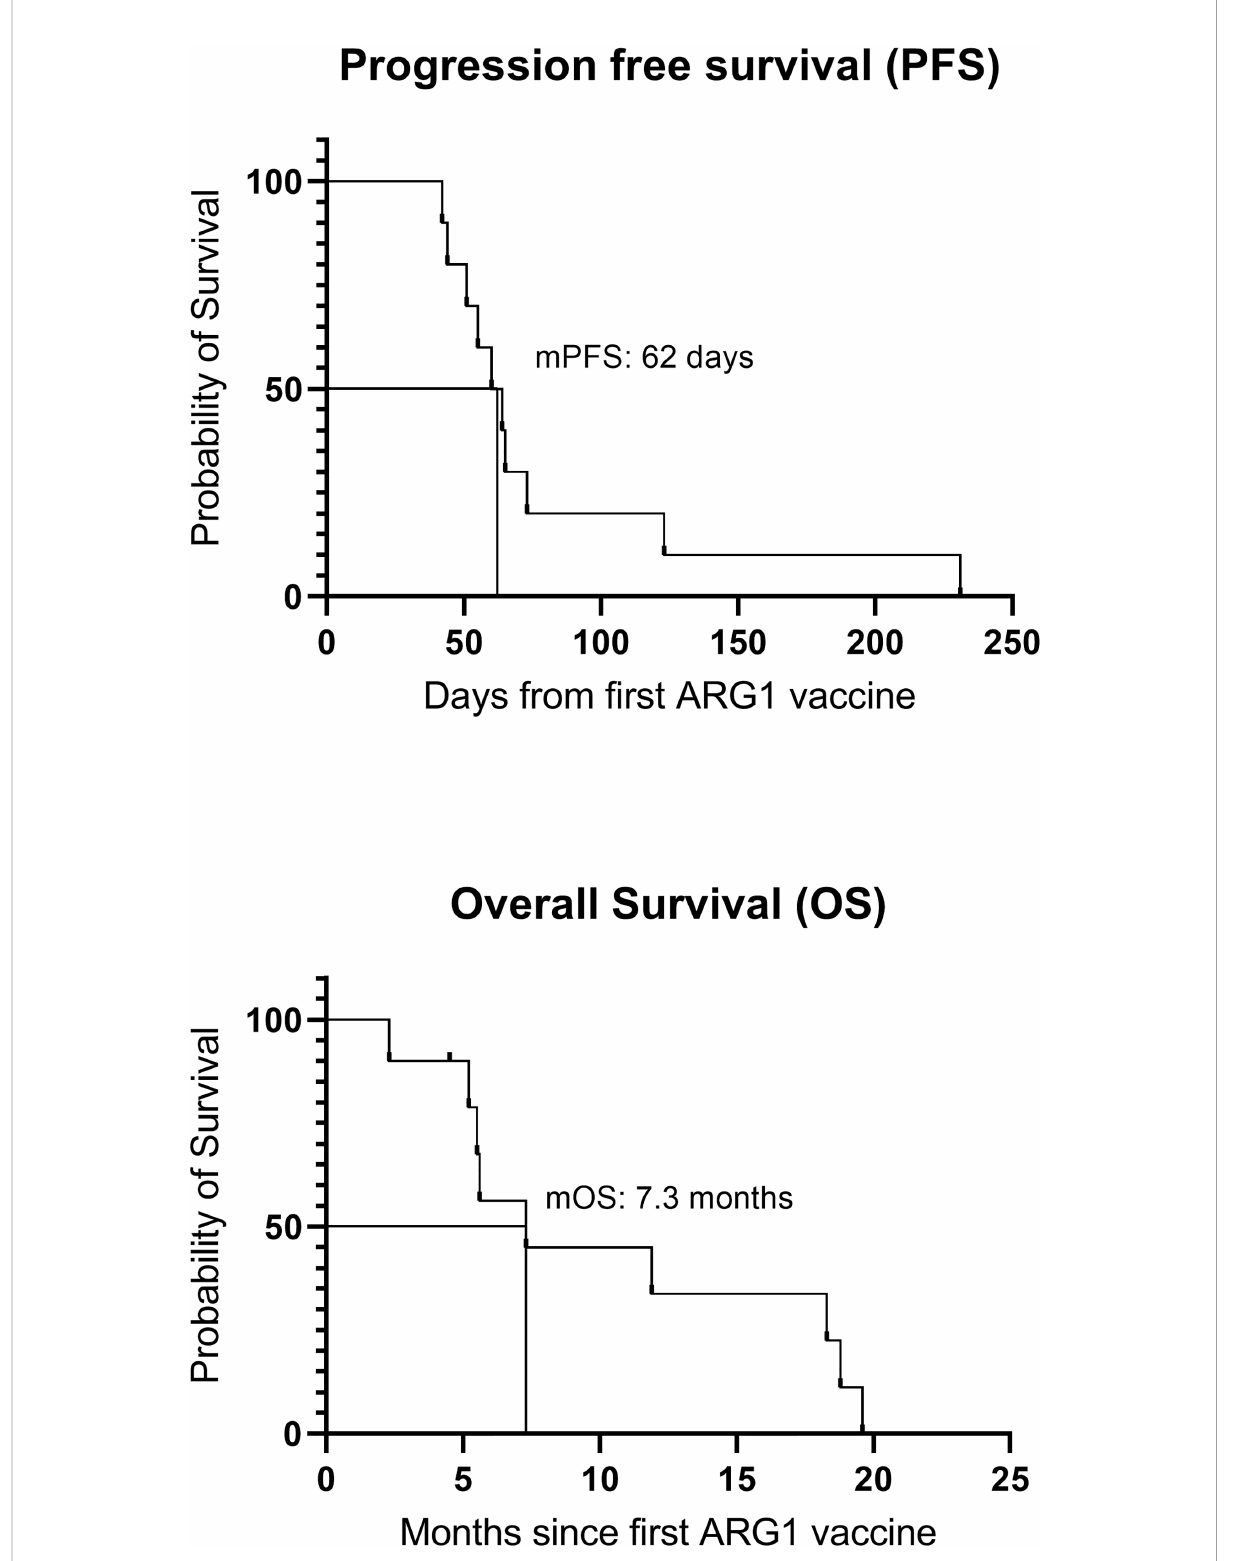
FIGURE 5 Overall survival and progression-free survival. mPFS, median progression-free survival; mOS, median overall